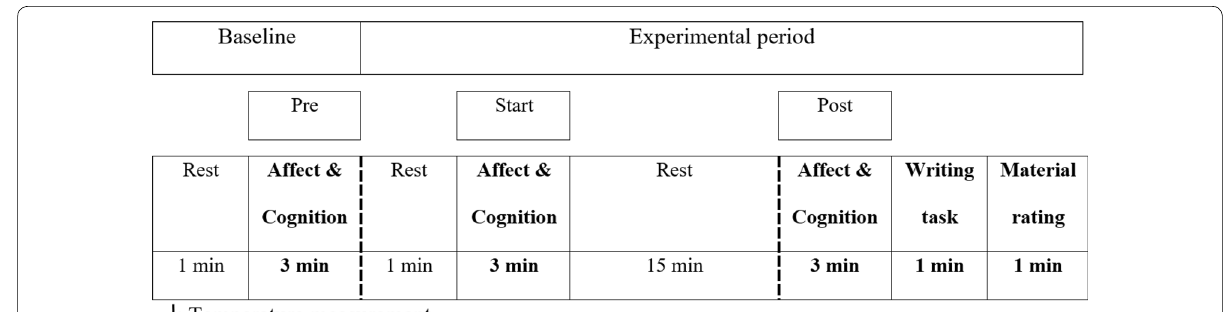
Fig. 3 Experimental